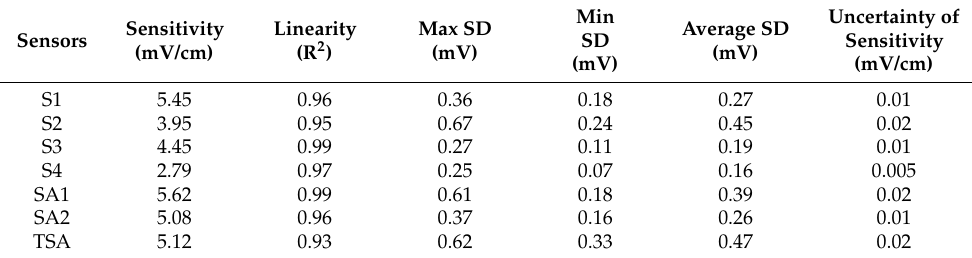
Table 1. Comparison between sensor sensitivity, linearity, and uncertainty when magnetized at 0.6 kA/m, 500 Hz and twisted 0.70 rad/cm (271 MPa torsion